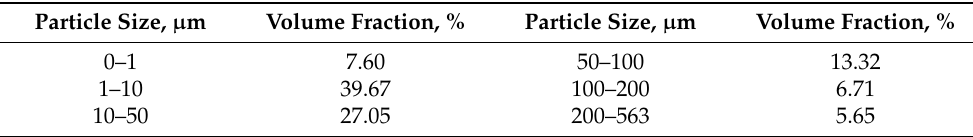
Table 2. Particle size distribution of desulphurization